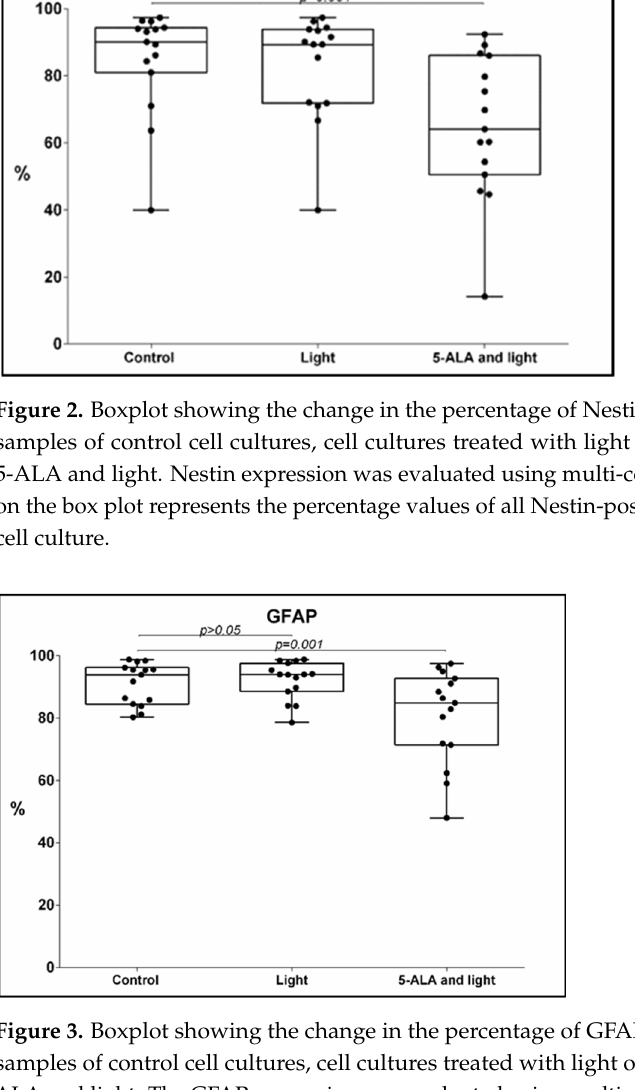
Figure 4. Boxplot showing the change in MFI levels of GFAP expression by GB-MS С s across paired samples of control cell cultures, cell cultures treated with light only, and cell cultures exposed to 5-ALA and light. The MFI GFAP expression was evaluated using multi-color flow cytometry, and every dot on the box plot represents the values of all GFAP-MFIs in that particular cell culture. 3.3. Sox2 Expression The GB-MSCs under the influence of the 5-ALA and light exposure had significantly lower expressions of Sox2 compared to the control GB-MSCs, a median MFI of 628 (24– 2794) (median, min.–max.) vs. 834 (24–4698) (median, min.–max.), p = 0.015, q = 0.016. The Sox2 MFI was positively correlated with the GFAP MFI. Spearman’s rho = 0.611, p = 0.016, Figure 5.